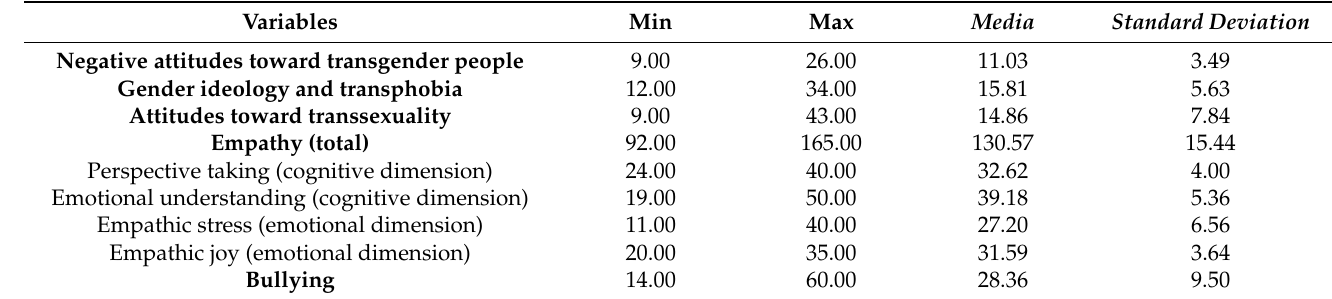
Table 1. Descriptive statistics of the negative attitudes toward transgender people, gender ideology and transphobia; attitudes toward transsexuality, cognitive and affective empathy; and bullying in university students.